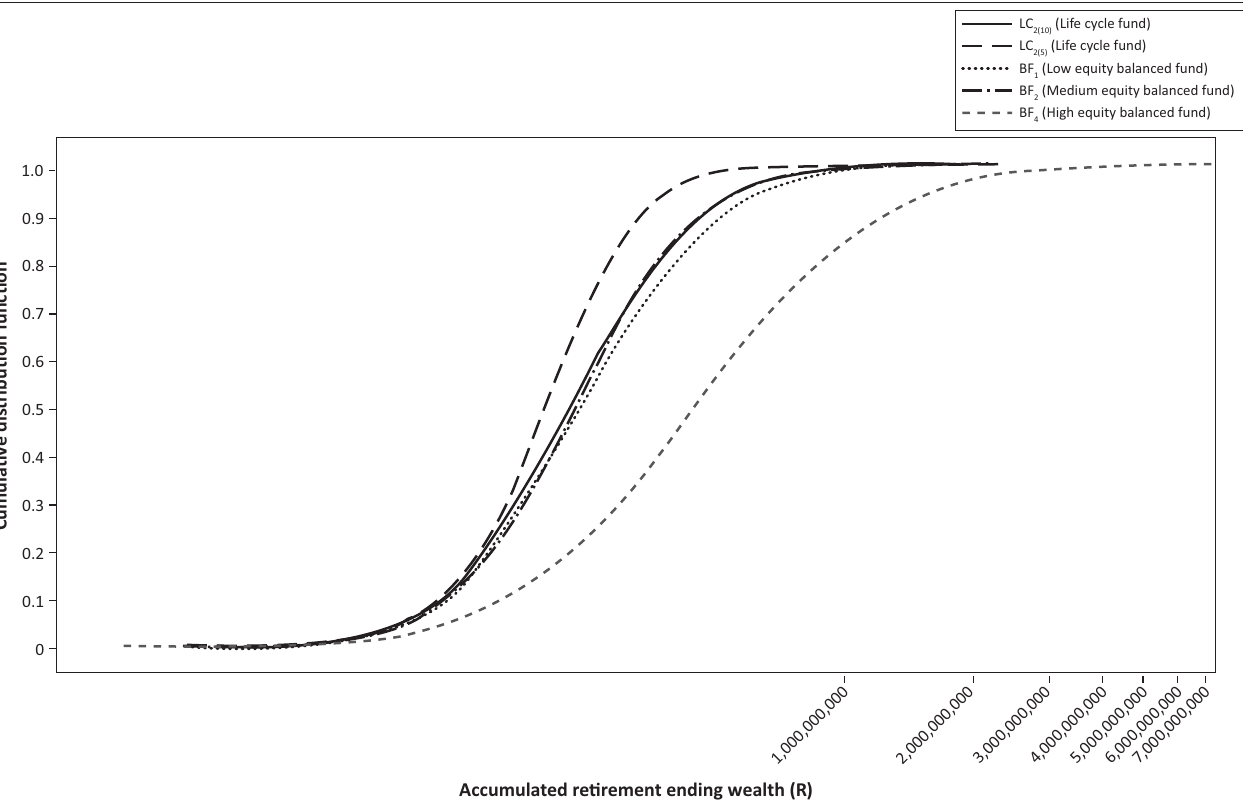
and LC against models BF , BF and BF . 2(10) 2(5) 1 2 3